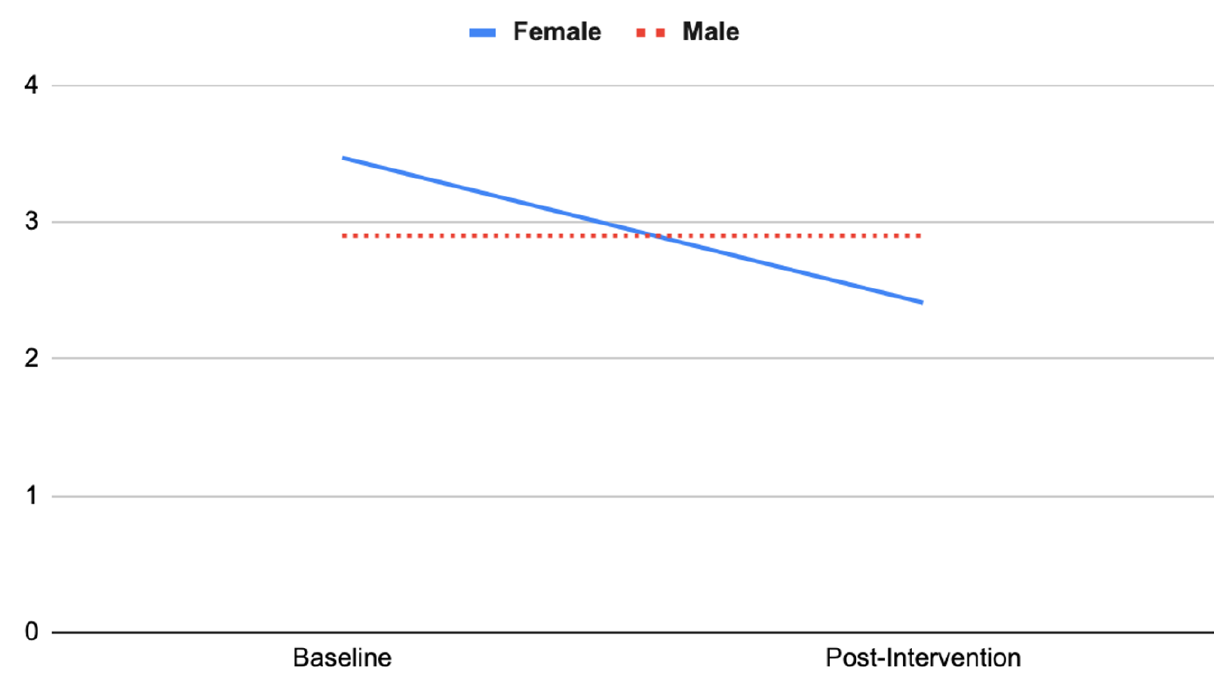
Figure 1. Interaction effect between gender and anxiety.